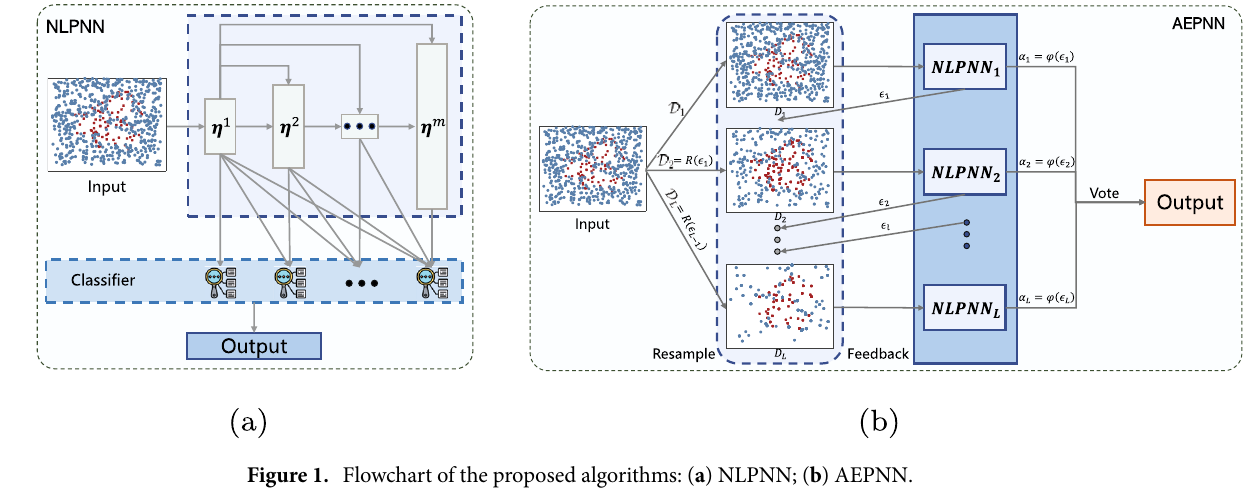
Figure 1. Flowchart of the proposed algorithms: ( a ) NLPNN; ( b )